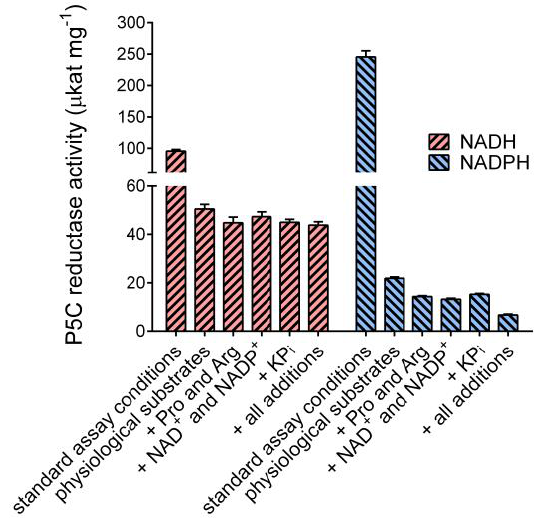
Figure 7. Influence of physiological concentrations of substrates and effectors on the activity of yeast P5C reductase. Enzyme activity was assayed under standard assay conditions (L-P5C 1 mM and NAD(P)H 0.5 mM), or in the presence of substrates and effectors at concentrations similar to those reported inside the yeast cell (L-P5C 100 µ M, NADH 500 µ M, NADPH 100 µ M, NAD + 1 mM, NADP + 200 µ M, Pro 1 mM, Arg 15 mM, and potassium phosphate 20 mM, pH 7.0), in a various array of combinations, as indicated. Results are mean ± SE over four replicates.